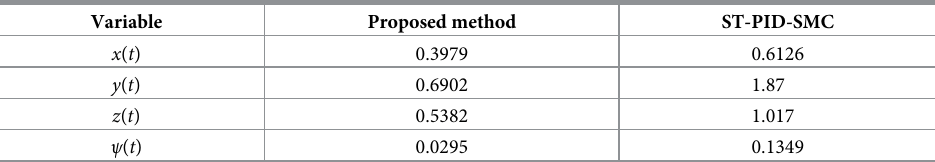
Table 4. IAE performance indexes of the scenario